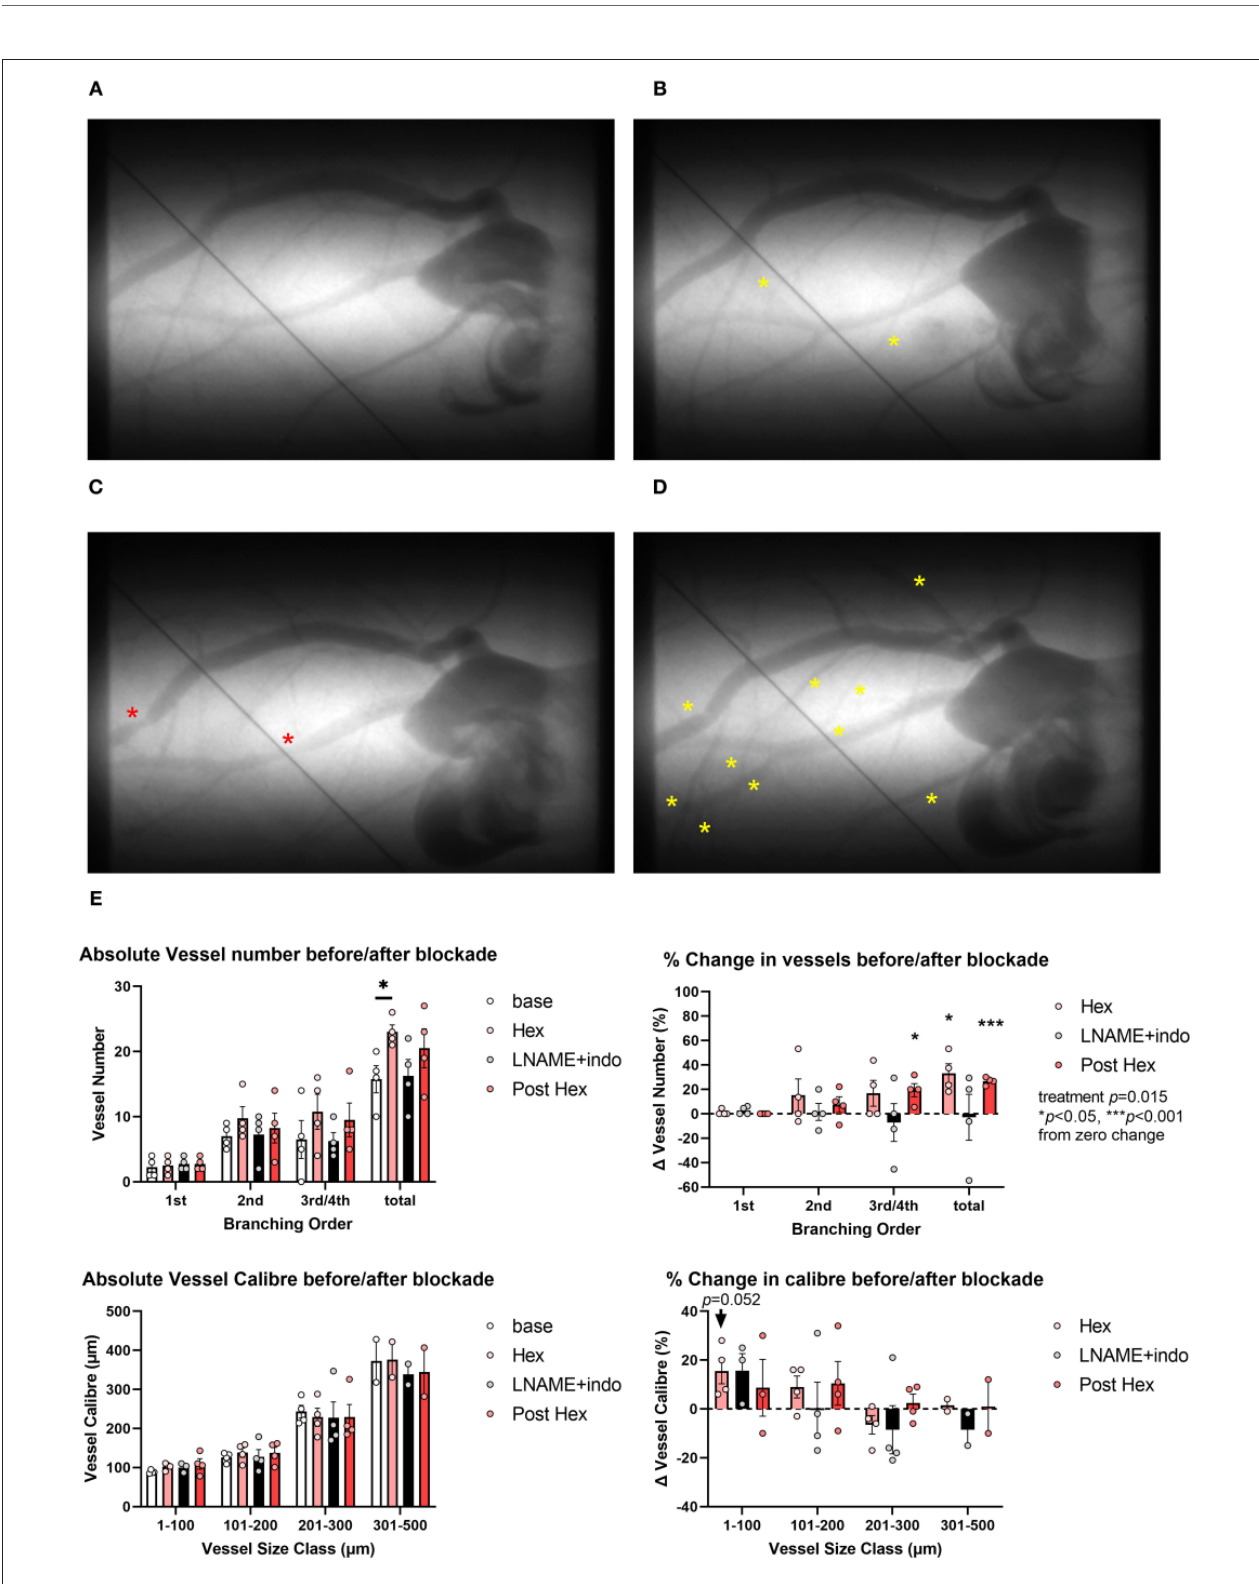
FIGURE 2 | Representative examples of microangiograms acquired from a normal Sprague-Dawley rat during repeated imaging after hexarelin (hex) administration before and after blockade of nitric oxide synthase and cyclooxygenase. (A) Baseline image. (B) Ten minutes after hexarelin administration (100 µ g · kg −